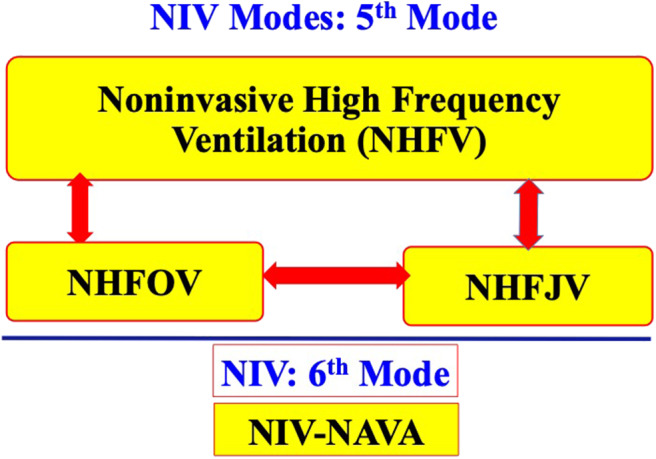
Newer modes of NIV.